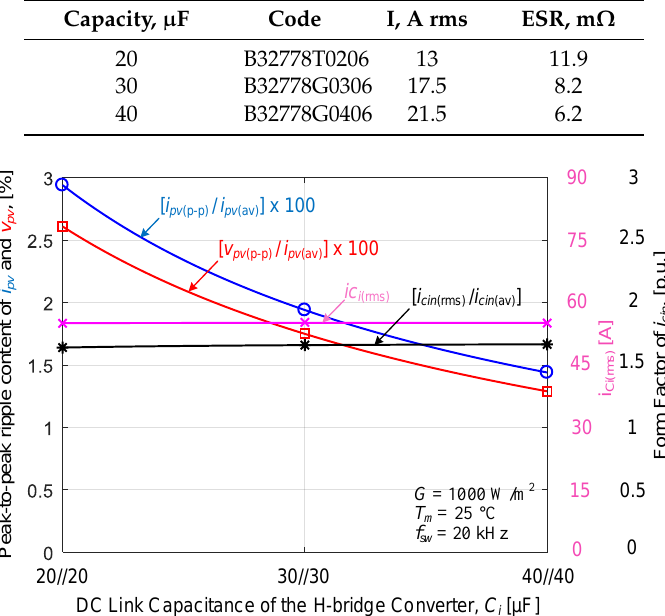
Table 2. Technical characteristics of some metallized film capacitors (1100 V DC at 70 °C) [74].